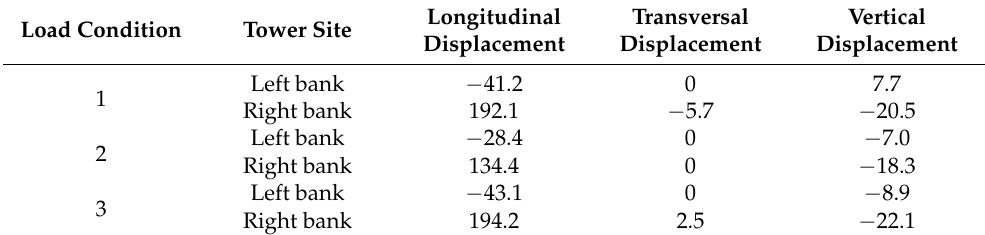
Table 5. Maximum measured displacement at tower top (unit: mm).